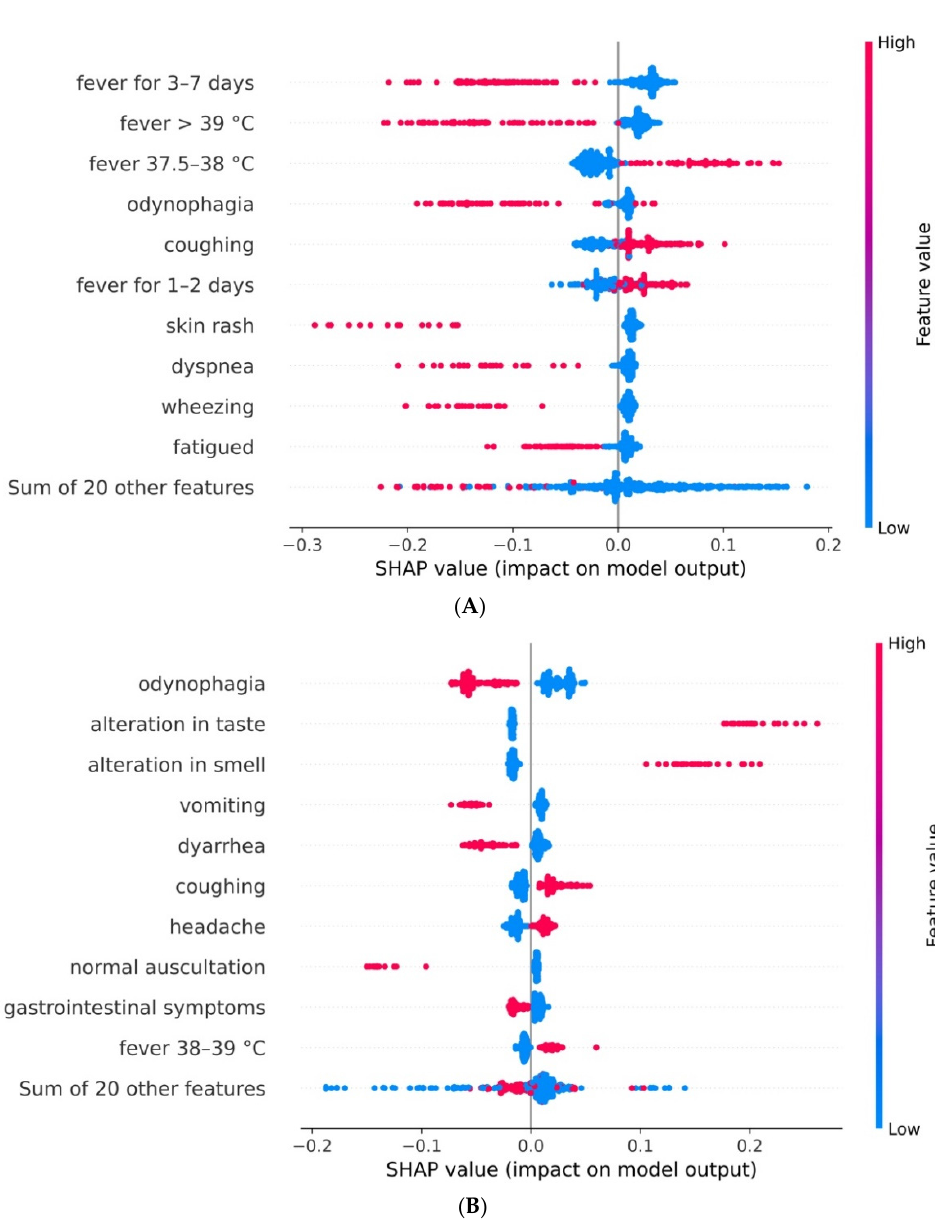
12 of 18 average features (Figures 2 and 3A) were also the top-10 maximum impact features (Fig- ure 3B), except nasal congestion and fever lasting for 1–2 days. ( A ) ( B ) Figure 3. ( A ) Absolute mean impact and ( B ) absolute maximum impact of each variable for the general model. 3.3.2. Model for Children by Age Range In the model trained for the dataset containing patients aged 0 to 5, having fever from 3 to 7 days, fever higher than 39 °C, odynophagia, visible skin rashes, shortness of breath, wheezing and fatigue all impacted negatively on the predicted likelihood of SARS-CoV-2 infection (Figure 4A). On the other hand, low fever (37.5 to 38 °C), cough and fever for 1